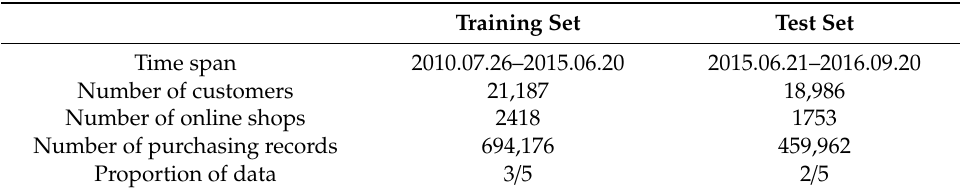
Table 1. Distribution of data and the division of training and test sets.